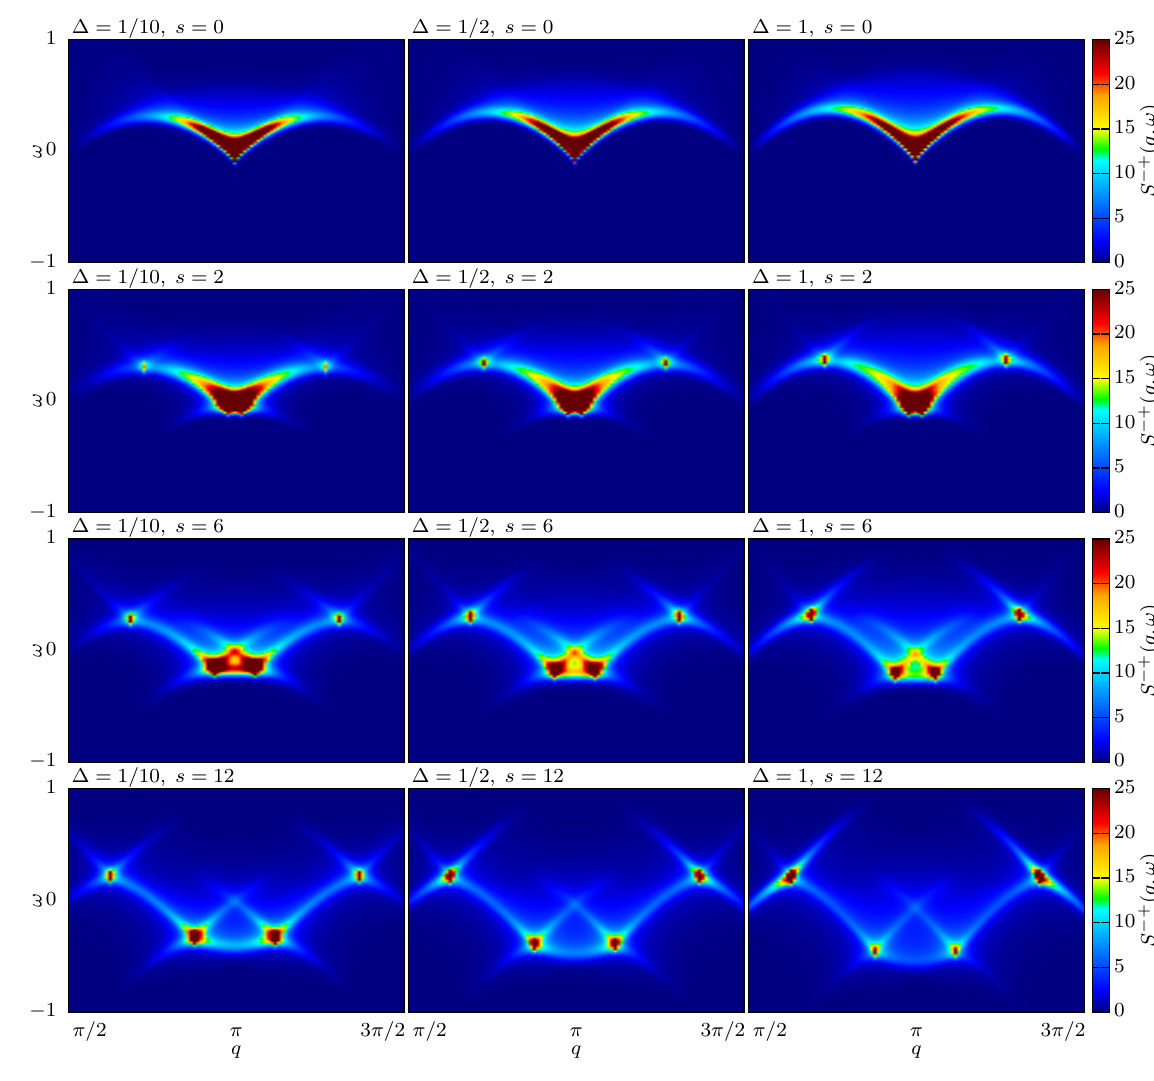
Figure 3: Transverse dynamical structure factor S − + ( q , ω ) at N = 200, M = 50 computed from summations of matrix elements obtained from algebraic Bethe Ansatz. From left to right, the anisotropies are ∆ = 1 , 1 ,1. From top to bottom, the momentum shifts in the quantum 10 2 numbers are s = 0,2,6,12. The corresponding sum rule saturations of the data are listed in Tab.